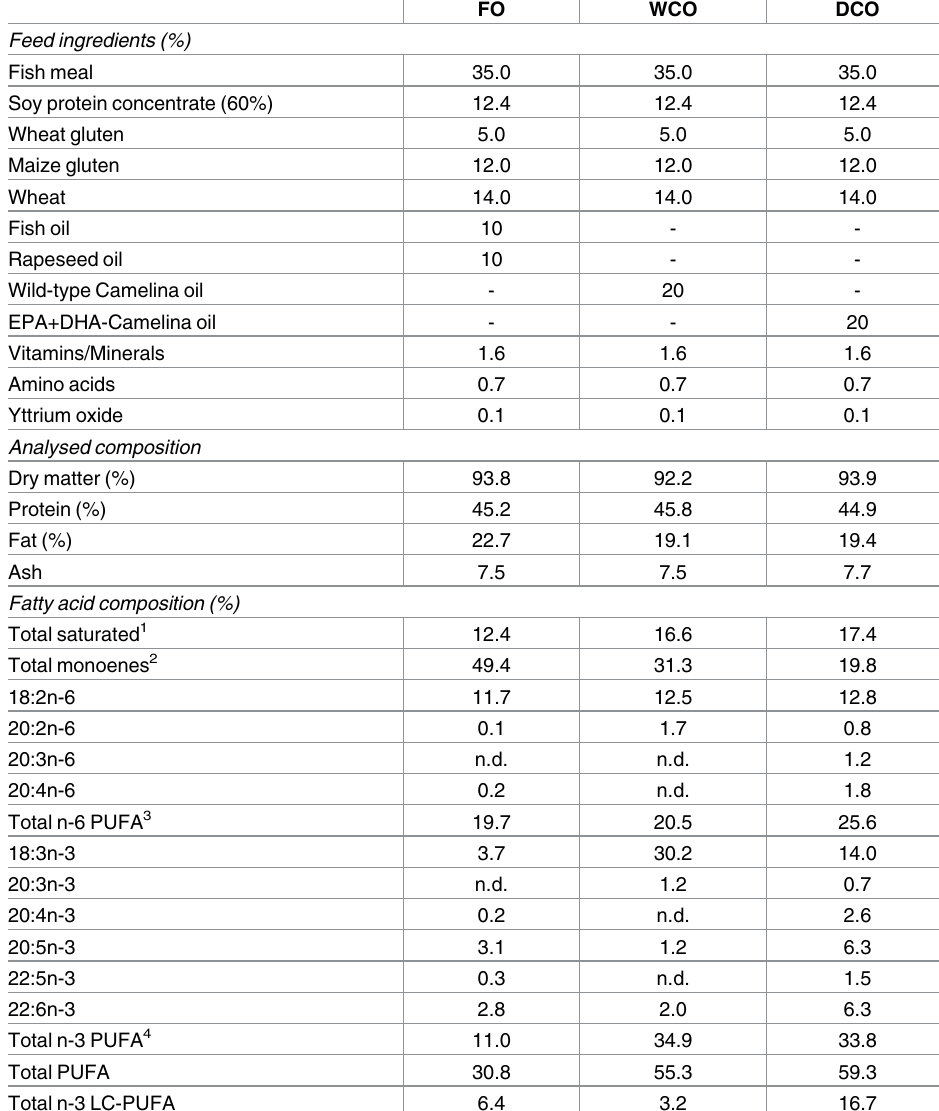
Table 1. Proximate and fatty acid compositions (percentage of fatty acids) of the three experimental feeds. FO WCO DCO Feed ingredients (%) Fish meal 35.0 35.0 35.0 Soy protein concentrate (60%) 12.4 12.4 Wheat gluten 5.0 5.0 Maize gluten 12.0 12.0 12.0 Wheat 14.0 Fish oil - Rapeseed oil - Wild-type Camelina oil - 20 -